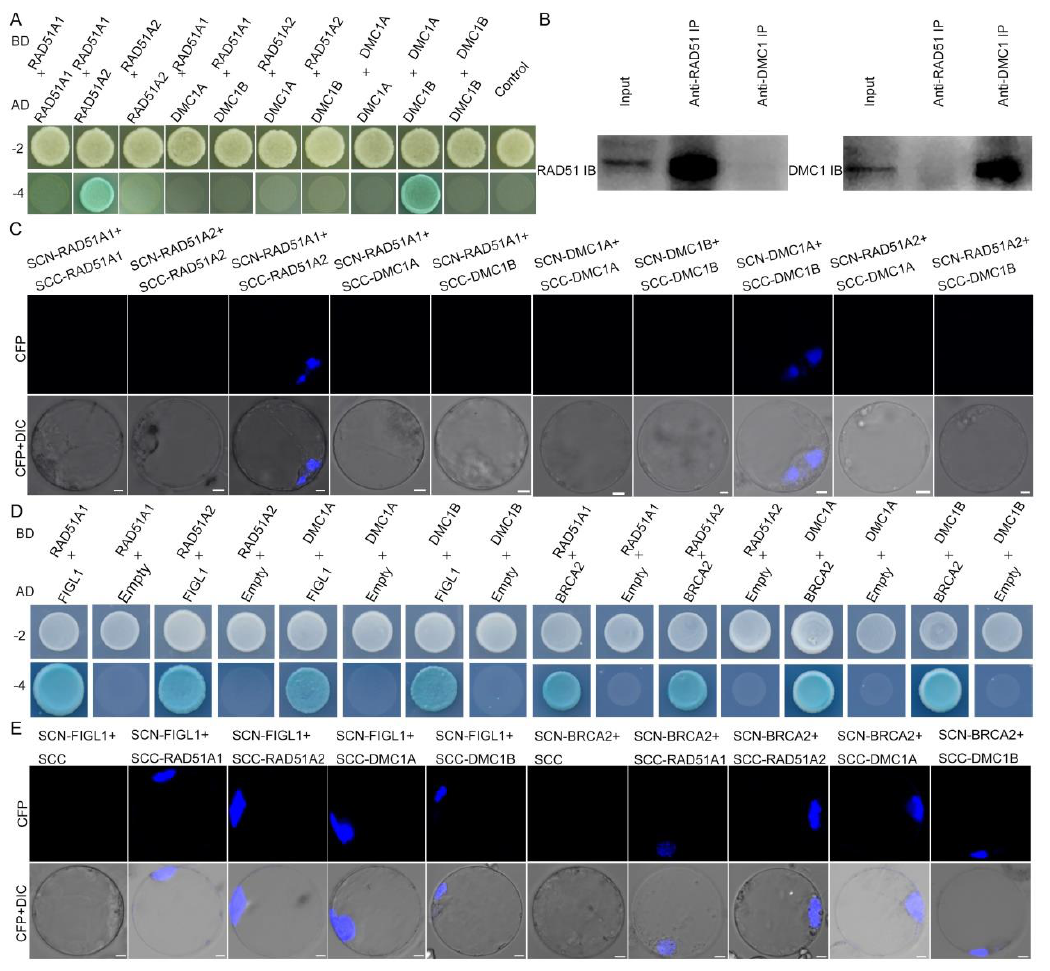
Figure 6. OsRAD51 cannot interact with OsDMC1, both OsRAD51 and OsDMC1 can interact with OsFIGL1 and OsBRCA2. ( A ). OSRAD51 cannot interact with OsDMC1 in yeast-two-hybrid (Y2H) assays. Interactions between bait and prey were examined on the control medium 2 (SD/−Leu/−Trp) and the selective medium 4 (SD/−Ade/−His/−L−u/−Trp). AD, prey vector pGADT7; BD, bait vector pGBKT7. ( B ). Coimmunoprecipitation assays showing that OsRAD51 cannot interact with OsDMC1. IB, immunoblot; IP, immunoprecipitation. ( C ). Bimolecular fluorescence complementation (BiFC) assays showing that OsRAD51 cannot interact with OsDMC1 in rice protoplasts. ( D ). OsRAD51 and OsDMC1 can interact with OsFIGL1 and OsBRCA2 in Y2H assays. ( E ). Bimolecular fluorescence complementation (BiFC) assays showing that OsRAD51 and OsDMC1 can interact with OsFIGL1 and OsBRCA2 in rice protoplasts. Bars, 5 μ m.